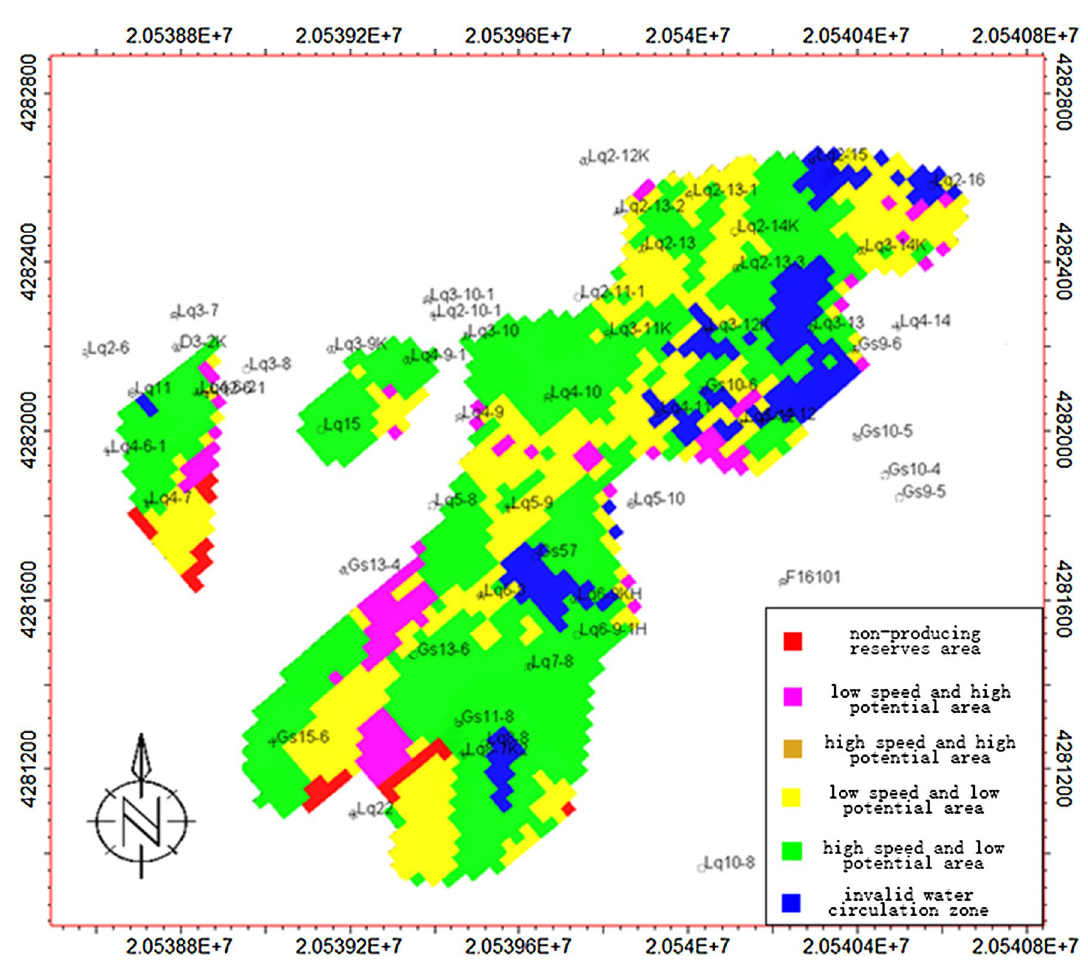
Fig. 11 Gang Dong oilfield Nm3-4-1 layer seepage field schematic diagram after adjustment Table 3 Comparison of parameter predictions before and after adjustment of the Nm3-4-1 layer seepage field Water cut (%) Accumulation of oil production, million tons Before